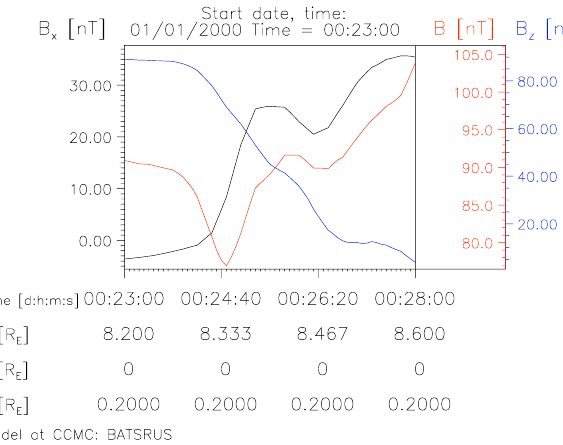
Fig. 5. Magnetic field data ( B x , B z , B ) from a virtual satellite cross- ing the northern part of the interlinked flux tubes. The satellite tra- jectory goes from the magnetosphere ( x = 8 . 2 R E ) to the magne- tosheath ( x = 8 . 6 R E ) at y = 0 and z = 0 . 2 R E . Red line refers to B , black to B x and blue to B z .